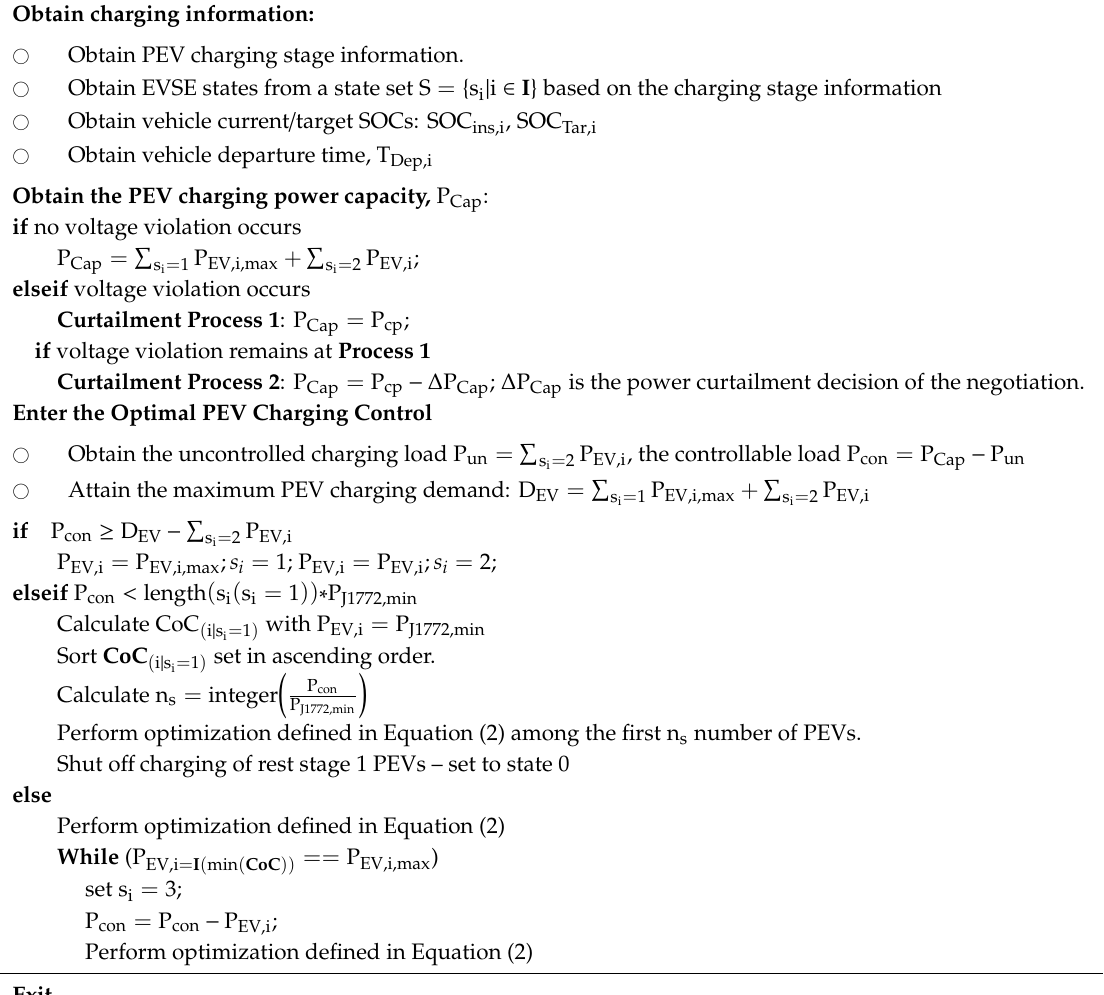
The CoC-based Optimal VGI Microgrid Control